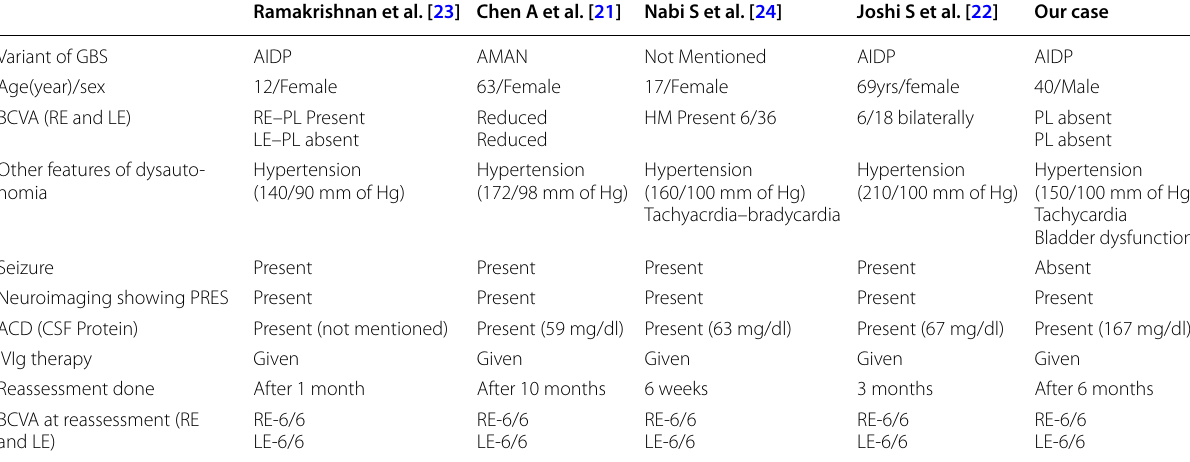
GBS Guillain–Barré syndrome, AIDP acute inflammatory demyelinating polyradiculoneuropathy, AMAN acute motor axonal polyneuropathy, PL projection of light, HM hand movement, mm millimetre, Hg mercury, mg milligram, dl decilitre, BCVA vest corrected visual acuity, CSF cerebrospinal fluid, IV Ig intravenous immunoglobulin, RE right eye, LE left eye, ACD albuminocytological